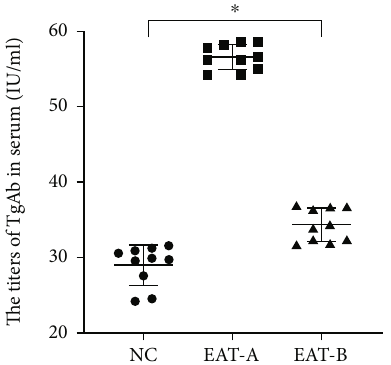
Figure 3: Serum TgAb titers. There were signi fi cant di ff erences among the three groups ( F = 435 : 793 , ∗ P < 0 : 001 , one-way ANOVA). Interestingly, the titers in EAT-B mice were signi fi cantly decreased compared to EAT-A mice ( P < 0 : 001 , LSD test) but signi fi cantly higher compared to NC mice ( P < 0 : 001 , LSD